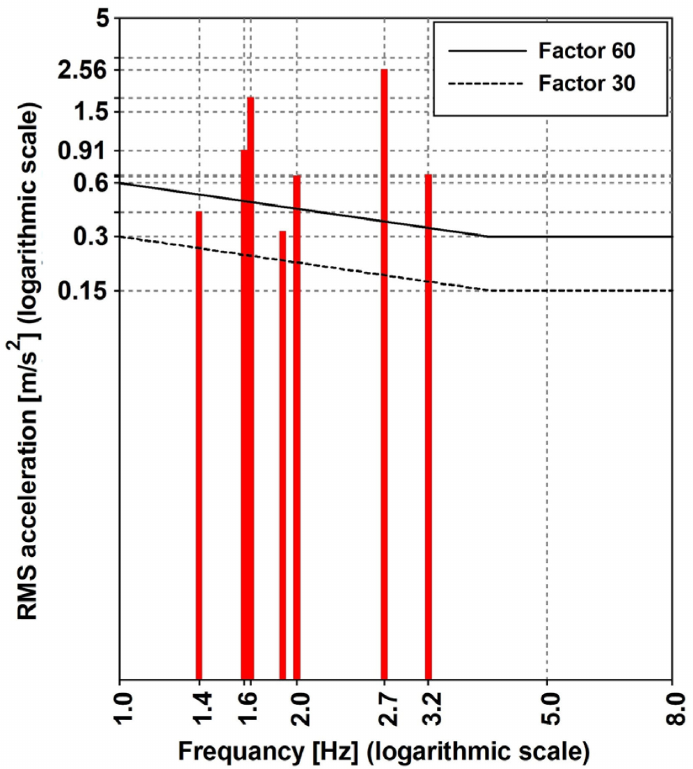
Figure 16. The ISO 10137:2007 [42] comfort criteria assessment for the vertical